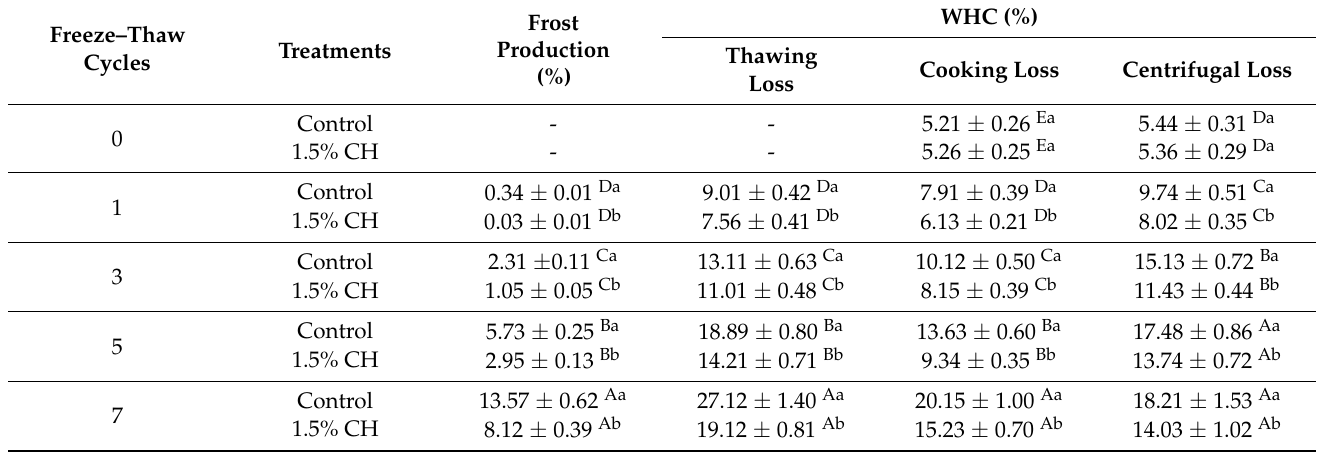
Table 2. Influence of chitosan ice coating on frost production and WHC of fish balls during freeze– thaw